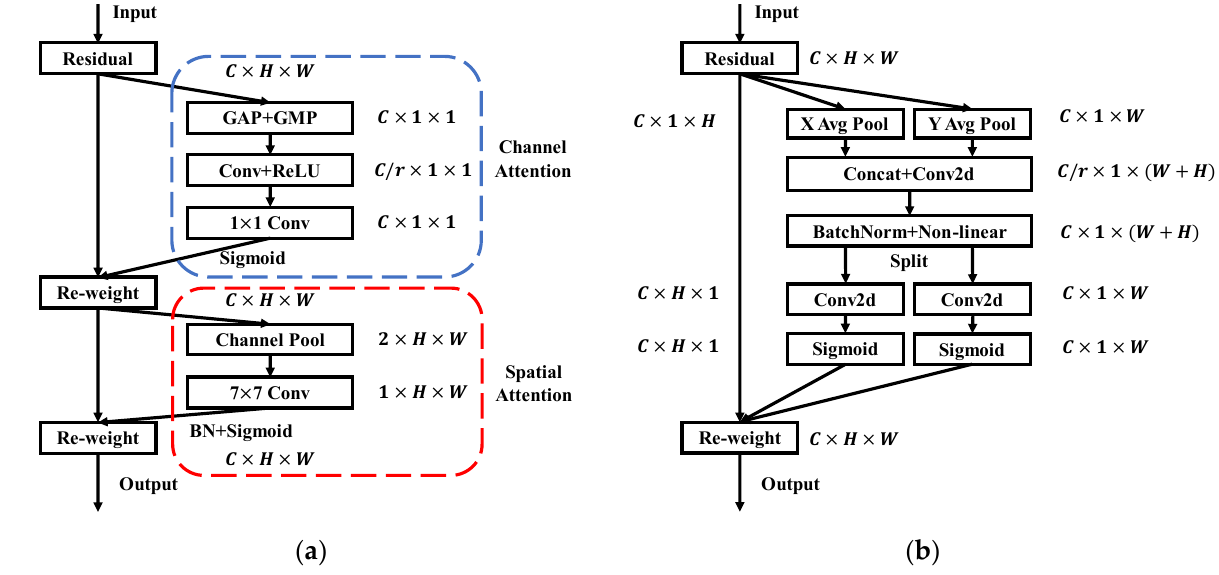
Figure 6. Diagram of attentional mechanism: ( a ) Convolutional block attention mechanism; ( b ) Coordinate attention mechanism.